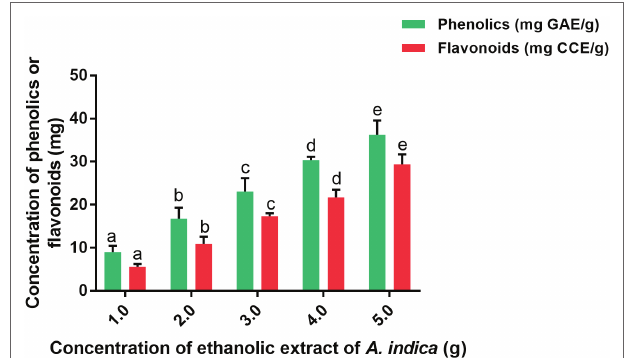
FIGURE 1 | Total phenolics (mg GAE/g) and flavonoids (mg CCE/g) in ethanolic extract of A. indica (AI). The experiments were performed individually in six replicates and achieved results were stated as mean ± standard deviation. The data were statistically evaluated by one-way ANOVA following Tukey’s post hoc multiple comparison test. The statistical variance among the experimental groups was measured as significant at p < 0.05. The columns with different alphabets were significant within the respective